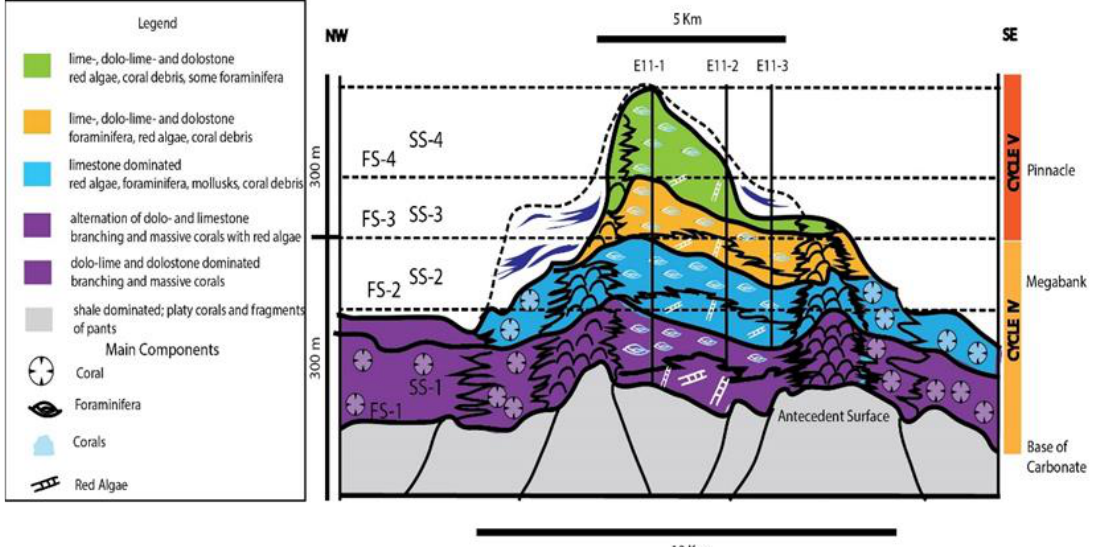
Figure 5. The lithological distribution model of the E11 platform and stratigraphic intervals.